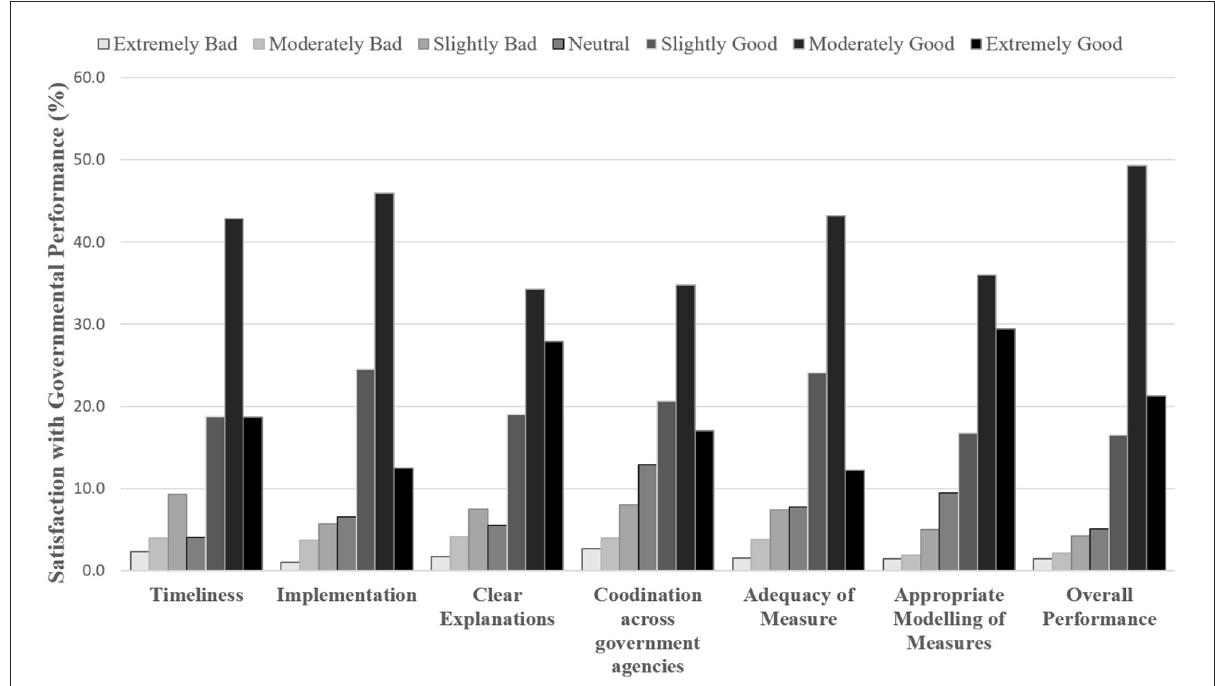
FIGURE1 Satisfaction of participants with government measures (N =